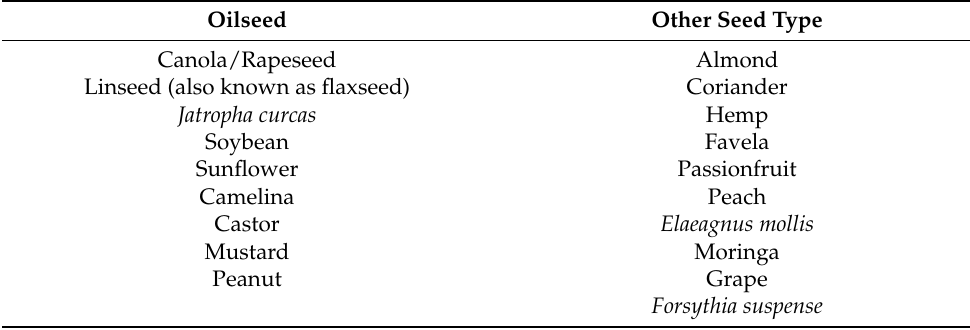
Figure 1. Priorities of the food recovery hierarchy, from most desirable (1) to least desirable (6). Adapted from [3]. Table 1. Types of extracted seed matrices in research studies covered in this literature